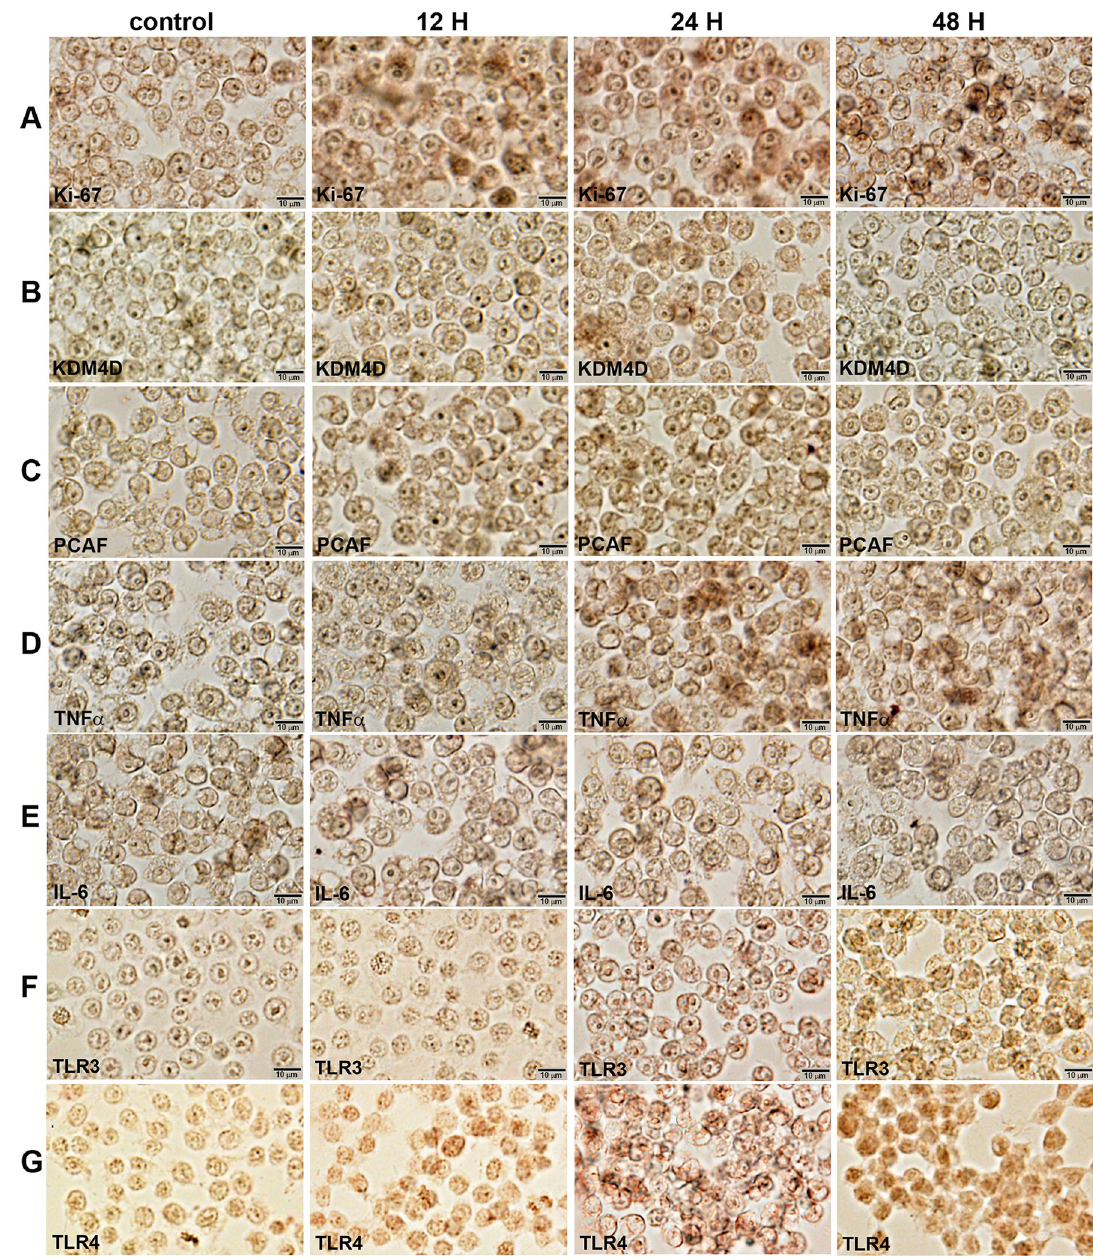
Fig 2. Immunocytochemical staining of Ki-67 (A), KMD4D (B), PCAF (C), TNF α (D), IL-6 (E), TLR3 (F), and TLR4 (G) in RAW 264.7 cells after 10 μ g/mL PTX treatment for 0, 12, 24, and 48 hours. Noted the cytoplasmic (arrow heads) and nuclear (arrows) localization of different immunoreactions in monocytic round cells. No counter